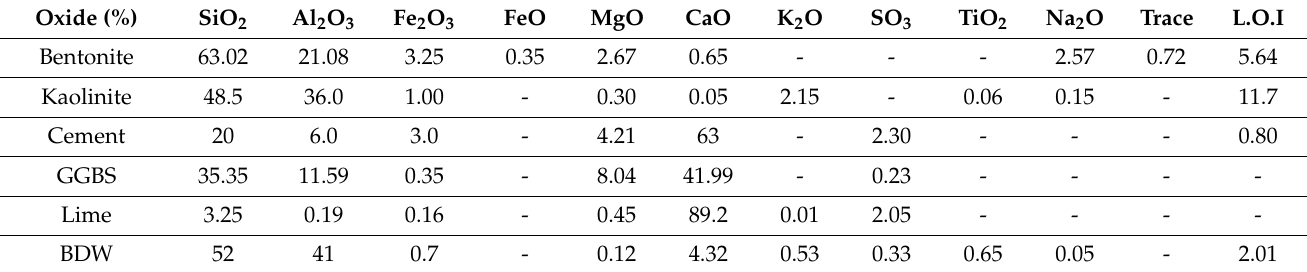
Table 1. Chemical Composition of Materials